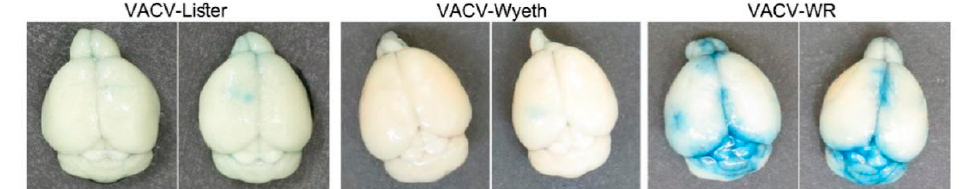
Figure 4. Infection with VACV-WR results in BBB breakdown and elevated levels of MMP-9. Mice were infected i.c. with VACV-Lister (10 6 pfu, n = 4), VACV-Wyeth (10 6 pfu, n = 5) or of VACV-WR (10 2 pfu, n = 5). Perfused brains of VACV-Lister (left; 6 d.p.i), VACV-Wyeth (middle; 5 d.p.i.) and VACV-WR (right; 5 d.p.i.) following Evans-blue peripheral administration (two representative brains from each strain). Blue color represents vasculature dysfunctional leakage, a hallmark of BBB breakdown.